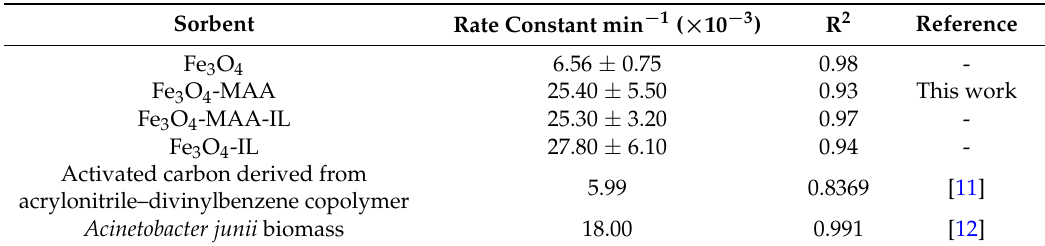
Figure 5. Adsorption kinetics: ( A ) Adsorption capacity with respect to contact time and ( B ) Rate of adsorption with respect to contact time (pH 2.0); ( a ) Fe 3 O 4 -MAA; ( b ) Fe 3 O 4 -MAA-IL; ( c ) Fe 3 O 4 -IL. Table 1. Kinetic data obtained from stirred tank experiments at pH 2.0.